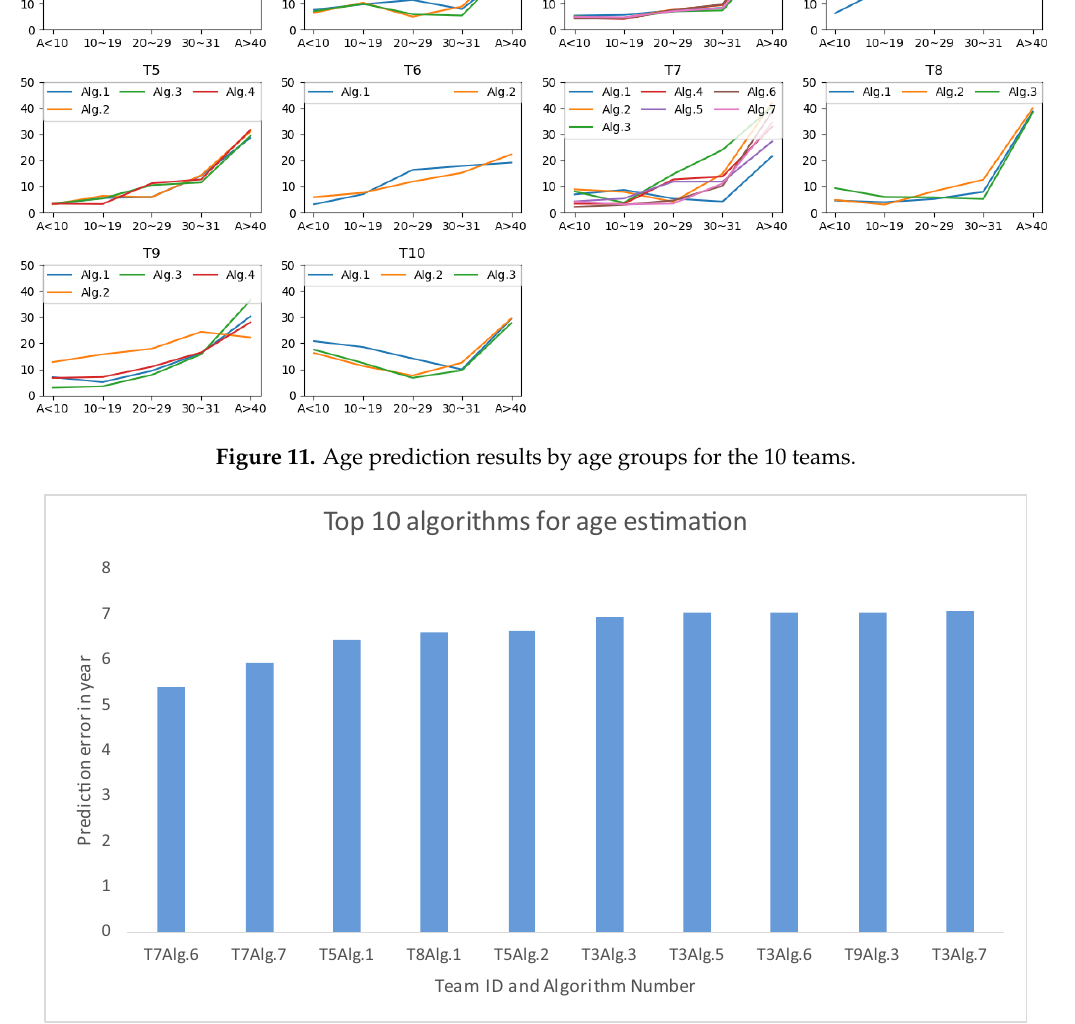
Figure 12. Top 10 algorithms, irrespective of any team for age prediction results by age groups. ‘T’ stands for ‘Team’ and ‘A’ stands for